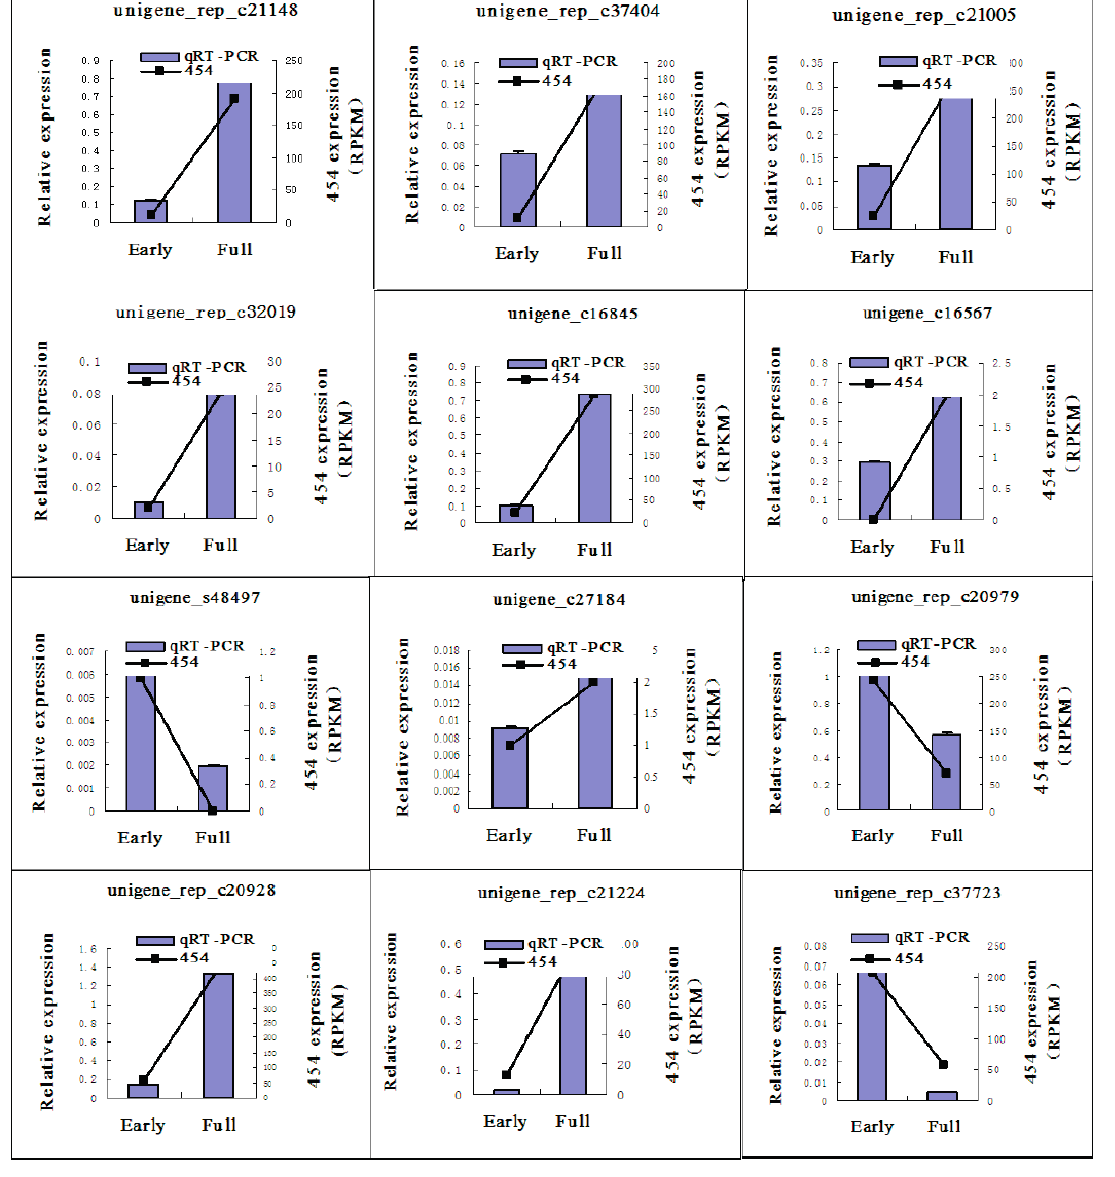
Figure 8. qRT-PCR validation of selected safflower unigenes. The qRT-PCR data are presented as the mean value of three repeats. “454” indicates the value of the unigene in 454 pyrosequencing. “Early” indicates the early flowering stage and “full” indicates the full flowering stage. Error bars indicate the standard deviation of the mean value of each